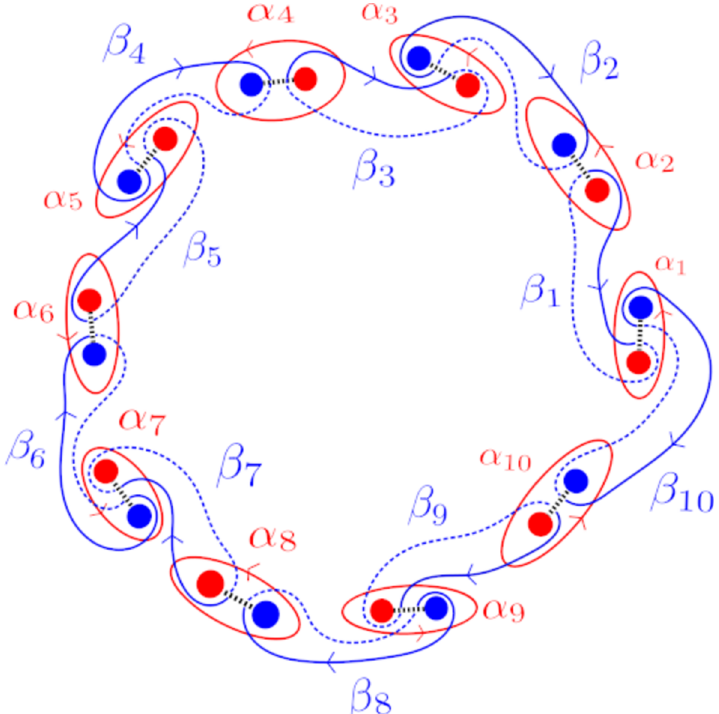
Figure 12 . We show (for N = 10 ) two sheets of the complex x -plane marked by the roots of W + (blue) and the roots of W − (red), with branch cuts running between them (black dots), at the origin of the Coulomb branch u 2 ,...,N = 0 . The cycles α i (red) run along the upper sheet, while the cycles β i (blue) run into the branch cuts and continue along the lower sheet (dotted